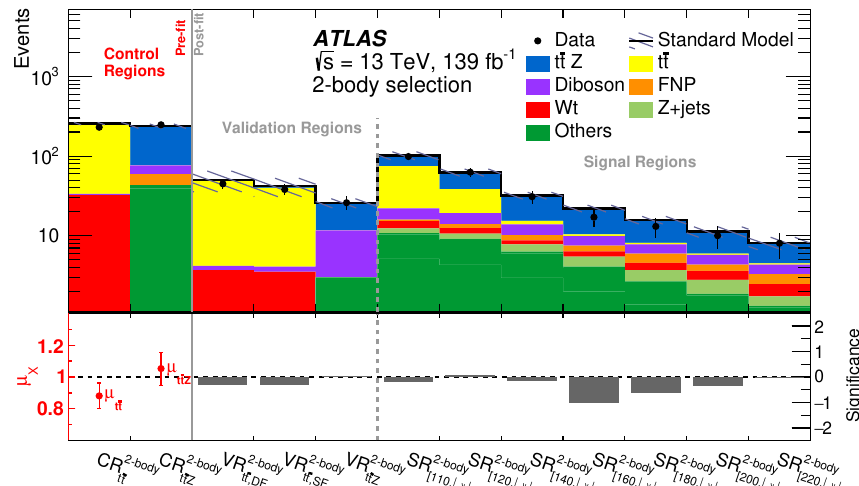
Figure 8 . Two-body selection. Expected and observed yields are shown. The upper panel shows the observed number of events in each of the CRs, VRs and the inclusive SRs defined in the two-body selection, together with the expected SM backgrounds obtained before the fit in the CRs and after the fit in the VRs and SRs. “Others” includes contributions from V V V , tt t , tttt , tt W , tt WW , tt WZ , tt H , and tZ processes. The shaded band represents the total uncertainty in the expected SM background. The lower panel shows the normalisation factors µ (left two bins) extracted in X the CRs for the tt and tt Z processes, while, for the VRs and the inclusive SRs (right bins), the significance as defined in ref. [125].